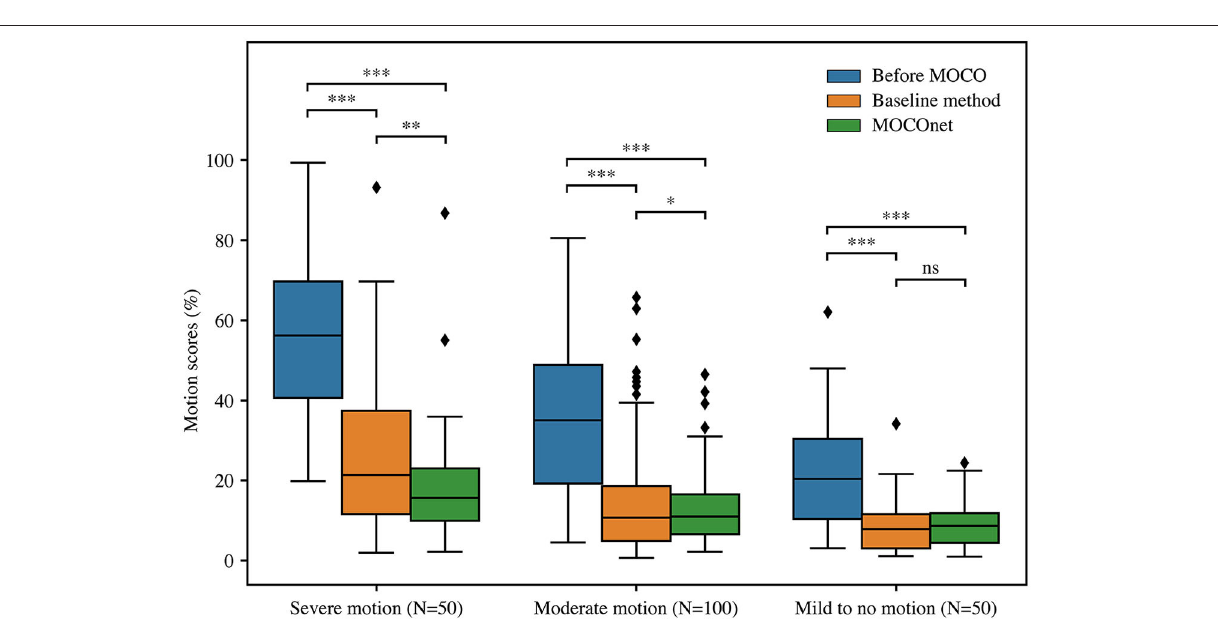
FIGURE 4 | Motion correction (MOCO) performance of the baseline and the proposed deep learning-based motion correction (MOCOnet) methods. Box and whisker plot of motion scores in non-parametric terms of three data groups, before (blue) and after motion correction by the baseline (orange) and proposed MOCOnet (green) methods. Reported values are inverse variance-weighted scores of three human observers. MOCOnet achieved the best results and significantly reduced the motion artefacts. * p = 0.04; ** p < 0.01; *** p < 0.001; ns = not